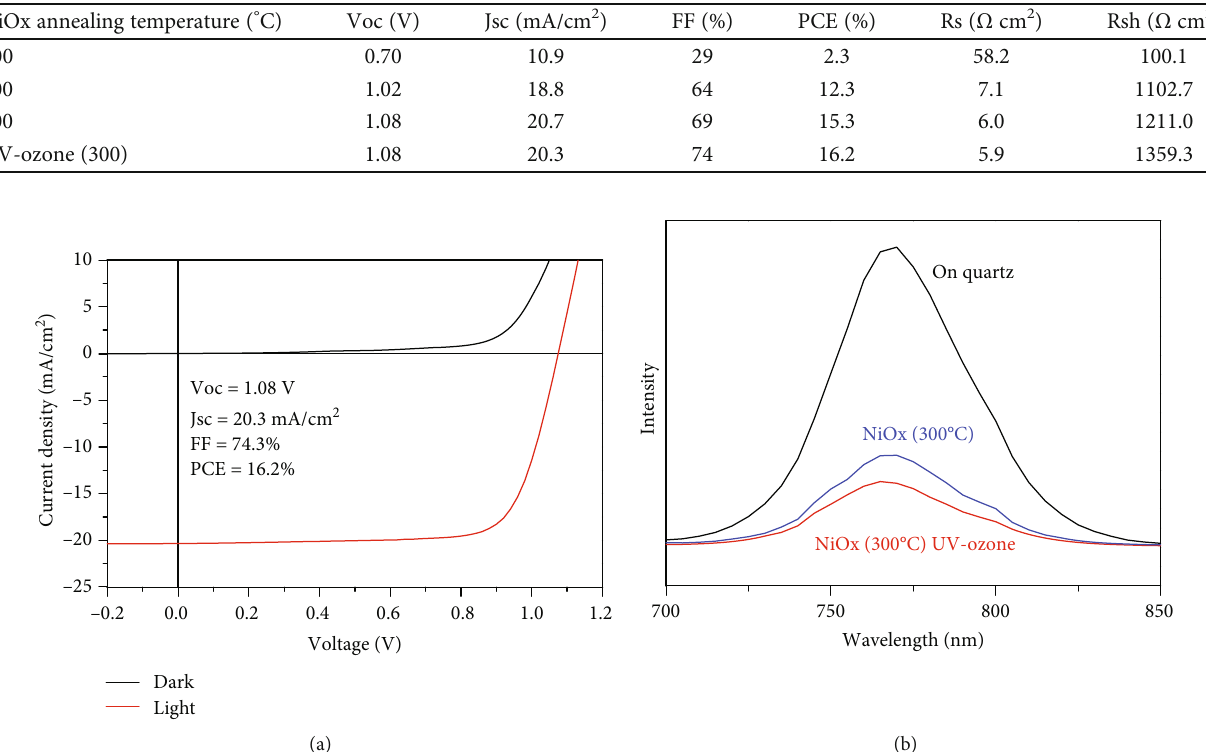
Figure 5: (a) The JV curve of the perovskite solar cell based on 300 ° C annealed NiOx with UV-ozone treatment. (b) The PL pro fi les of perovskite fi lms deposited on quartz, 300 ° C annealed NiOx with and without UV-ozone.